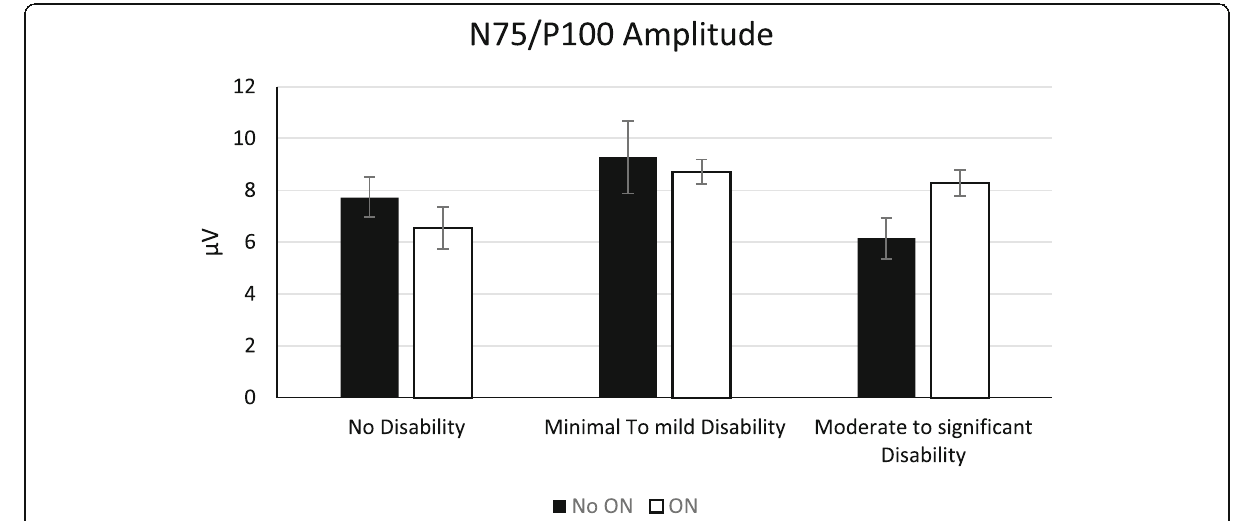
Fig. 2 Mean N75/P100 amplitude in the 3 patient groups with history of optic neuritis (ON) and without history of optic neuritis (No